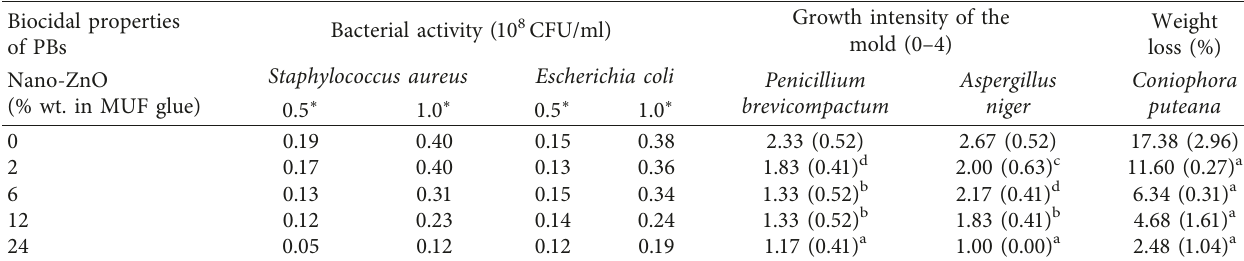
Table 2: Biological resistances of the control PB and the nano-ZnO-treated PBs against two bacteria, two molds, and the brown-rot fungus C. puteana.